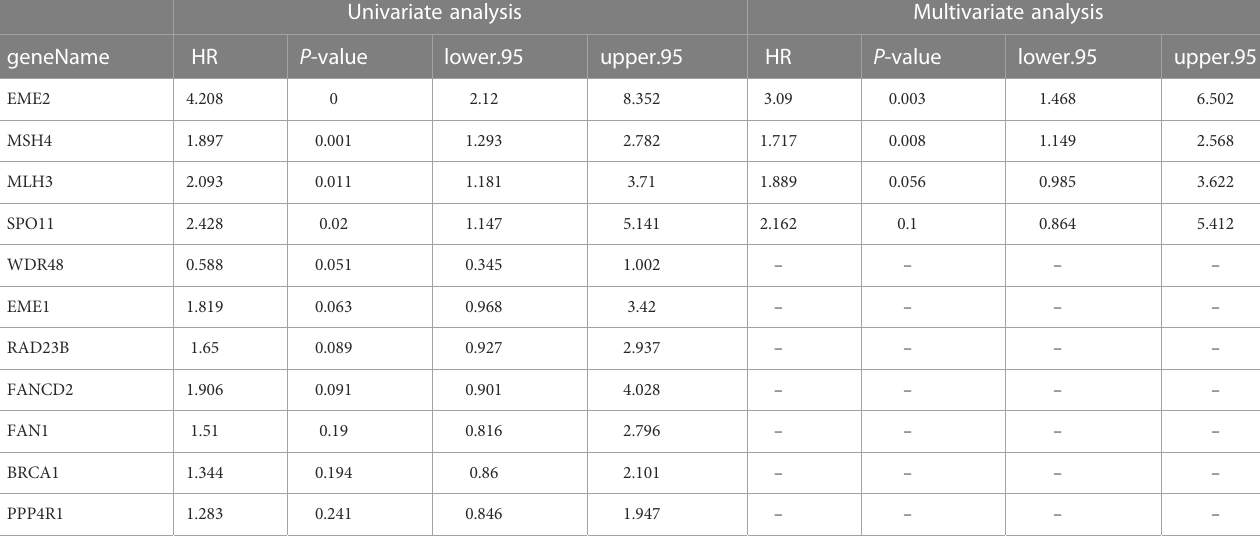
TABLE 2 Univariate and multivariate Cox regressions analysis of differentially expressed DDR genes. Univariate analysis Multivariate analysis lower.95 upper.95 lower.95